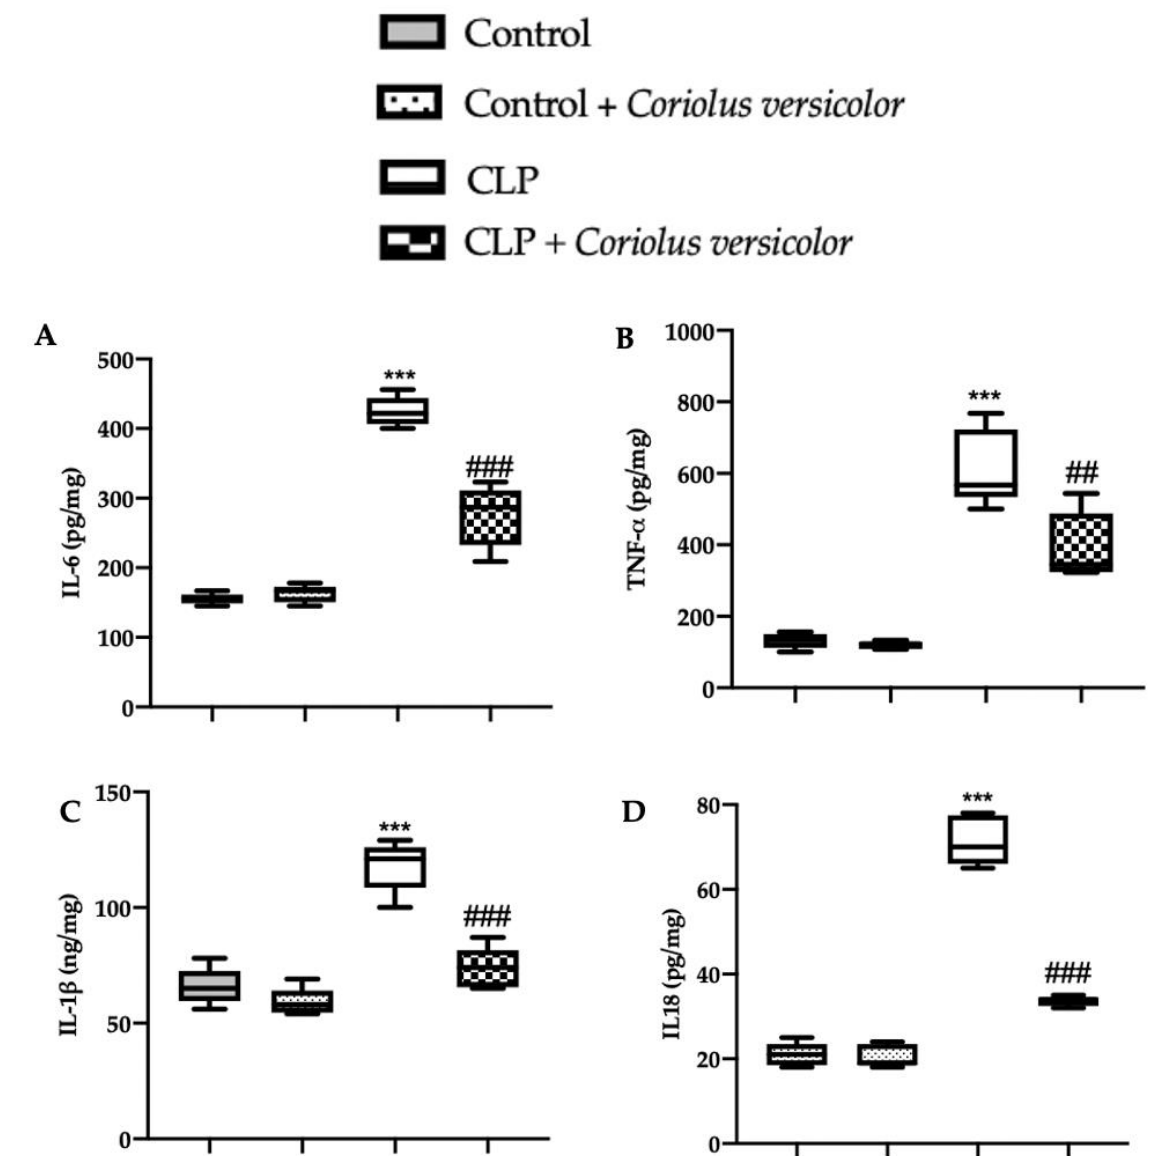
Figure 3. Coriolus versicolor reduced serum cytokines induced by CLP 28 days after surgery. Levels of serum interleukin (IL)6 ( A ), tumor necrosis factor (TNF)- α ( B ), IL-1 β ( C ), IL18 ( D ). *** p < 0.001 vs. Control, ## p < 0.01 vs. CLP, ### p < 0.001 vs. CLP.